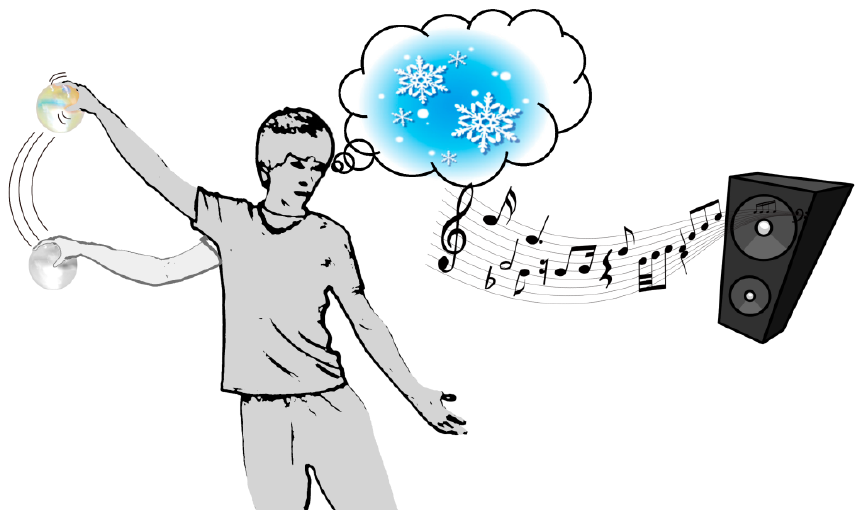
Figure 1. Conceptual diagram for the creative dance support of the proposed grasping-type interface. Motion and grasping force sensed by the interface are presented back to the user in real-time as a variation in musical sound. The sound encourages the user to generate motion continuously and accurately following the imagined trajectory. It also helps the user to conceive imagination for the next motions.